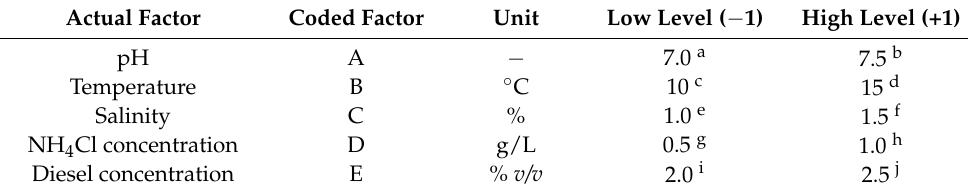
Table 1. Factors employed for response-surface methodology (RSM) analysis and their respective levels. Actual Factor Coded Factor Unit Low Level ( −